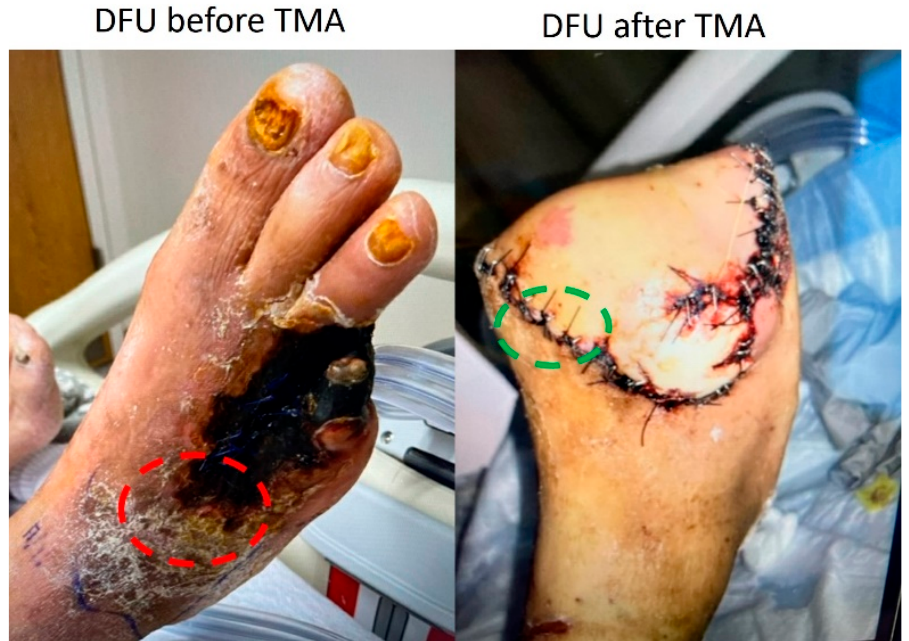
Figure 1. Tissues from the diabetic foot ulcer area (DFU, red circle) and clean samples near the margin of the wound (green circle) were collected from the human patient undergoing transmetatarsal amputation (TMA).